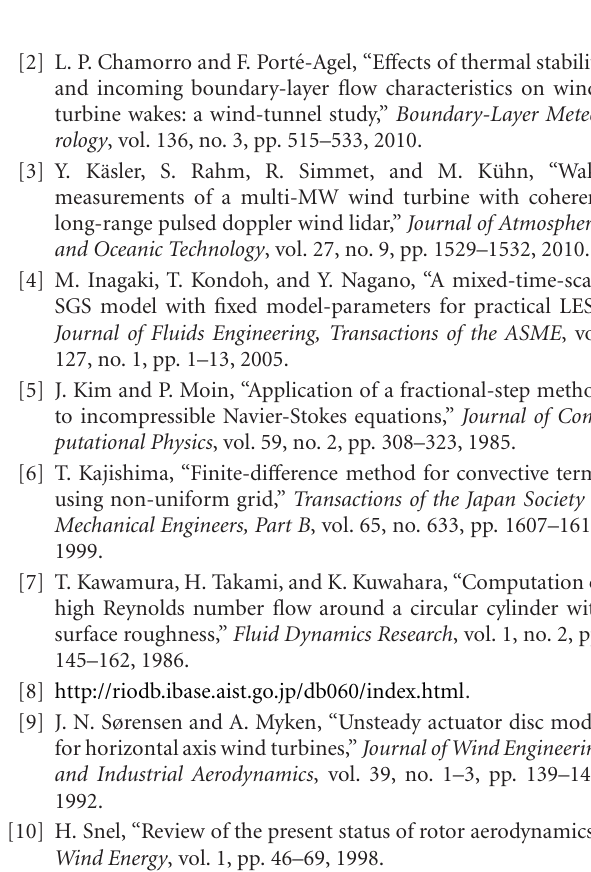
Figure 13: Same as Figure 12 except for the vertical profiles of time-averaged streamwise ( x ) velocity at y = 0. The z -coordinate of the rotor is shown with